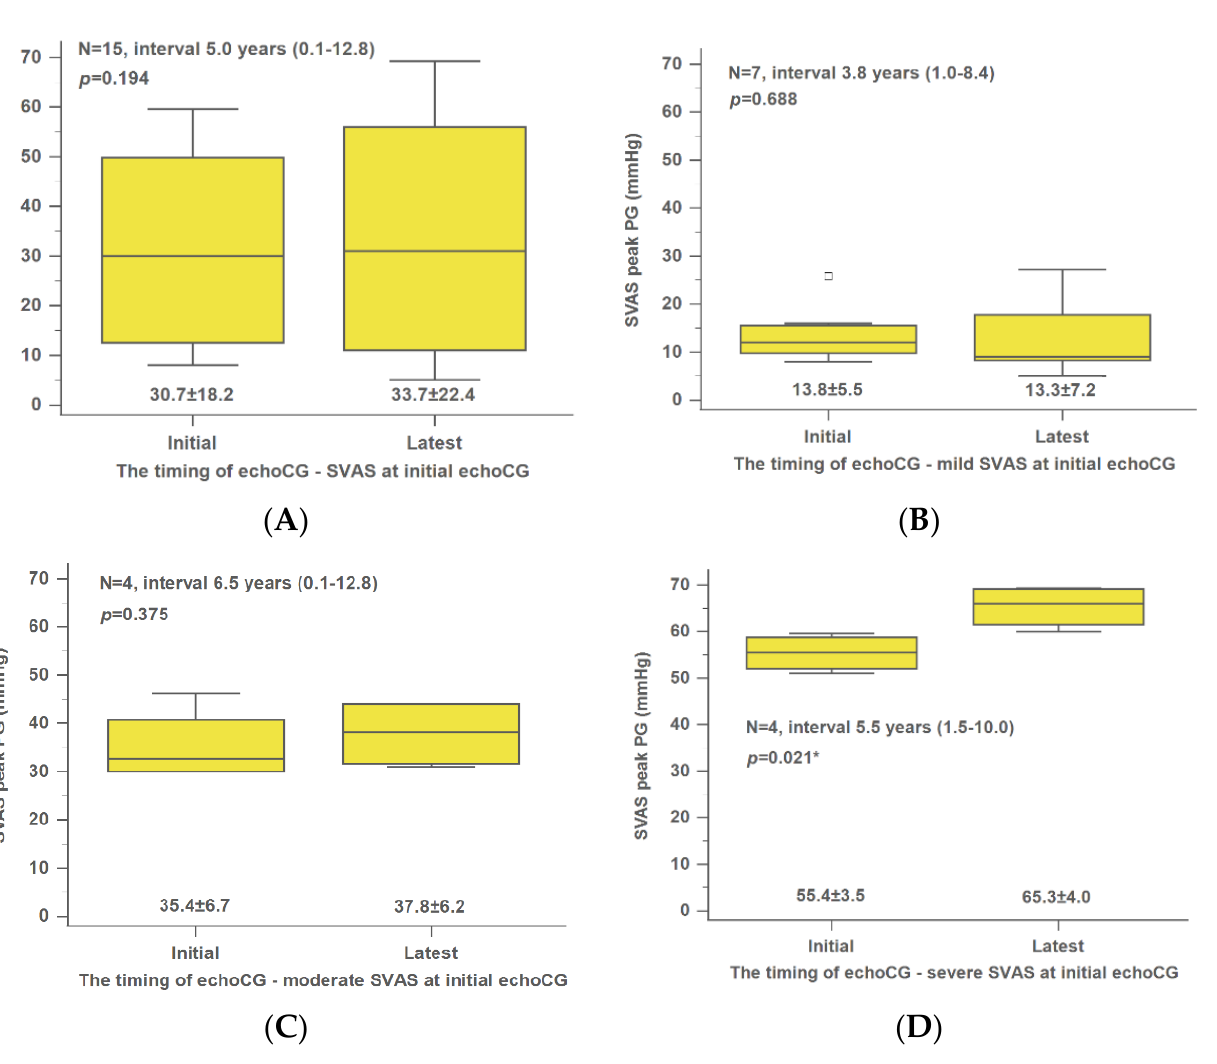
Figure 1. Changes in the mean peak velocity of overall ( A ), mild ( B ), moderate ( C ), and severe ( D ) SVAS at initial echocardiography. The interval was presented as the median value. echoCG, echocardiography; PG, pressure gradient; SVAS, supravalvular aortic stenosis. * p -value was calculated using the Wilcoxon signed-rank test.